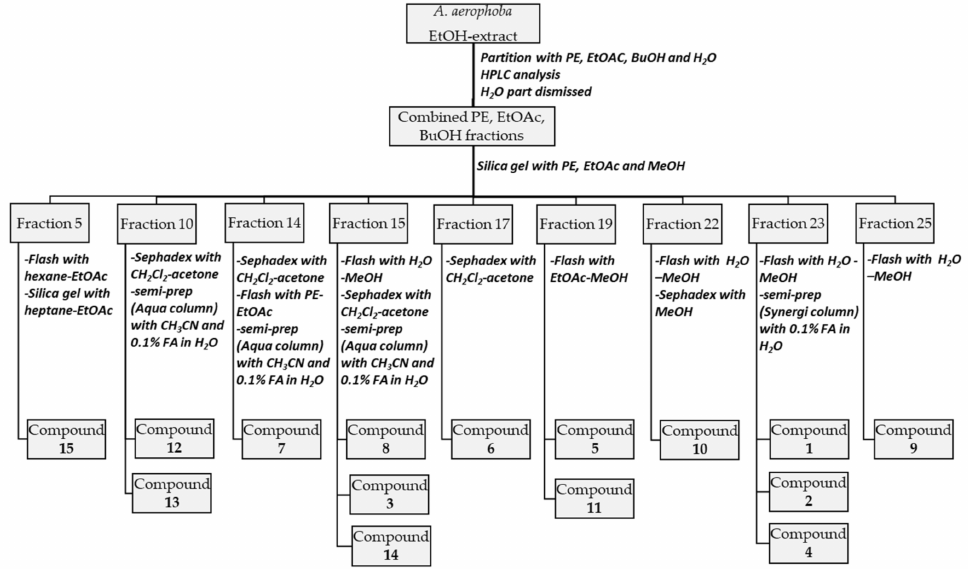
Figure 2. The isolation scheme for the A. aerophoba extract. The ethanolic extract of Spongia sp. was fractionated using similar approaches as described above, resulting in the isolation of 5 compounds (Figure 3).